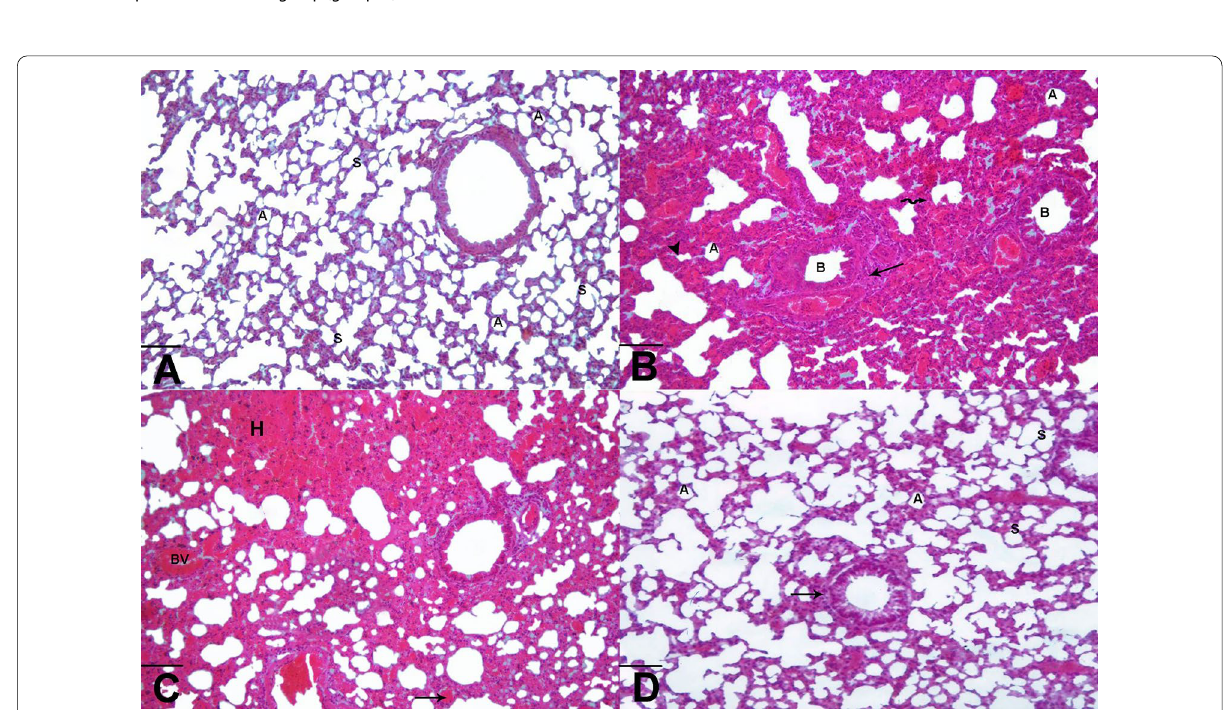
Data are expressed as mean standard deviation. Results were statistically analyzed by using Student’s t test at P < 0.05 ± a P < 0.0001 compared with the control group (group I) b P < 0.0001 compared with the CYP group (group III)